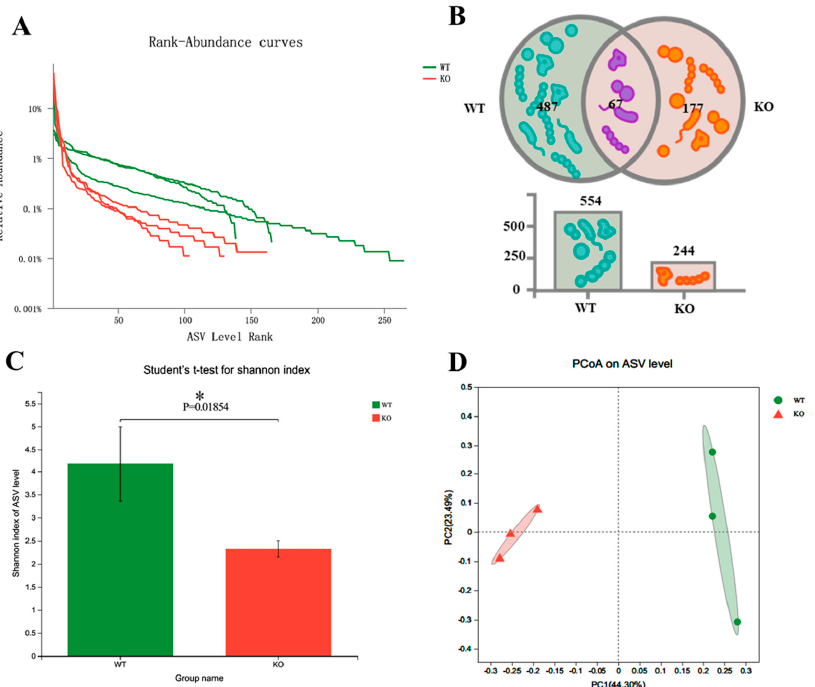
Figure 1. Diversity of gut microbiota in Atp11b -KO and WT mice. ( A ) Rank-abundance curves of WT (green) and KO (red) mice, representing the gut microbiota diversity. The x -axis indicates the ranking order of the number of ASVs, whereas the y -axis indicates the relative percentage abundance at the taxonomic level. ( B ) Venn diagram for the abundance of gut microbiota in WT and KO mice at the ASV level. ( C ) Community diversity of WT and KO mice according to the Shannon index. ( D ) PCoA of WT and KO mice based on the ASV level; a dot represents one mouse. For each group of mice, n = 3. Data are expressed as the mean ± SEM. Student’s t -test, * p < 0.05.